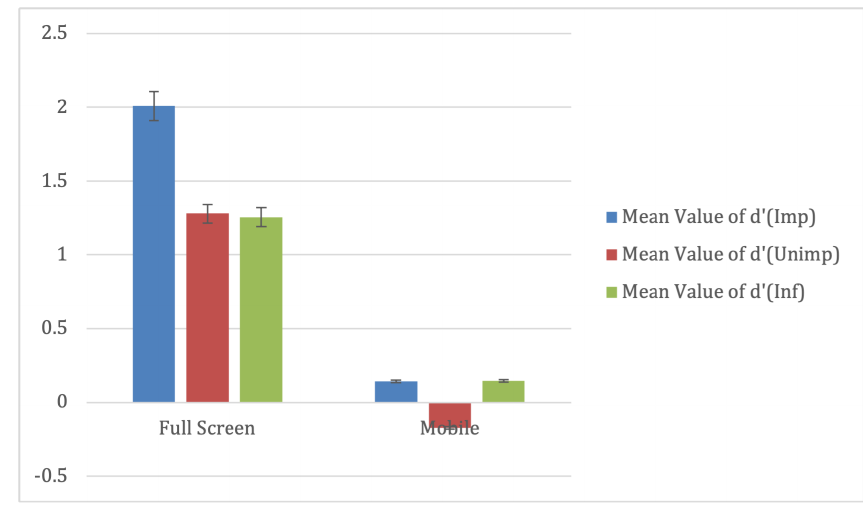
Figure 6. The mean and standard errors for sensitivity (d's) in each experimental